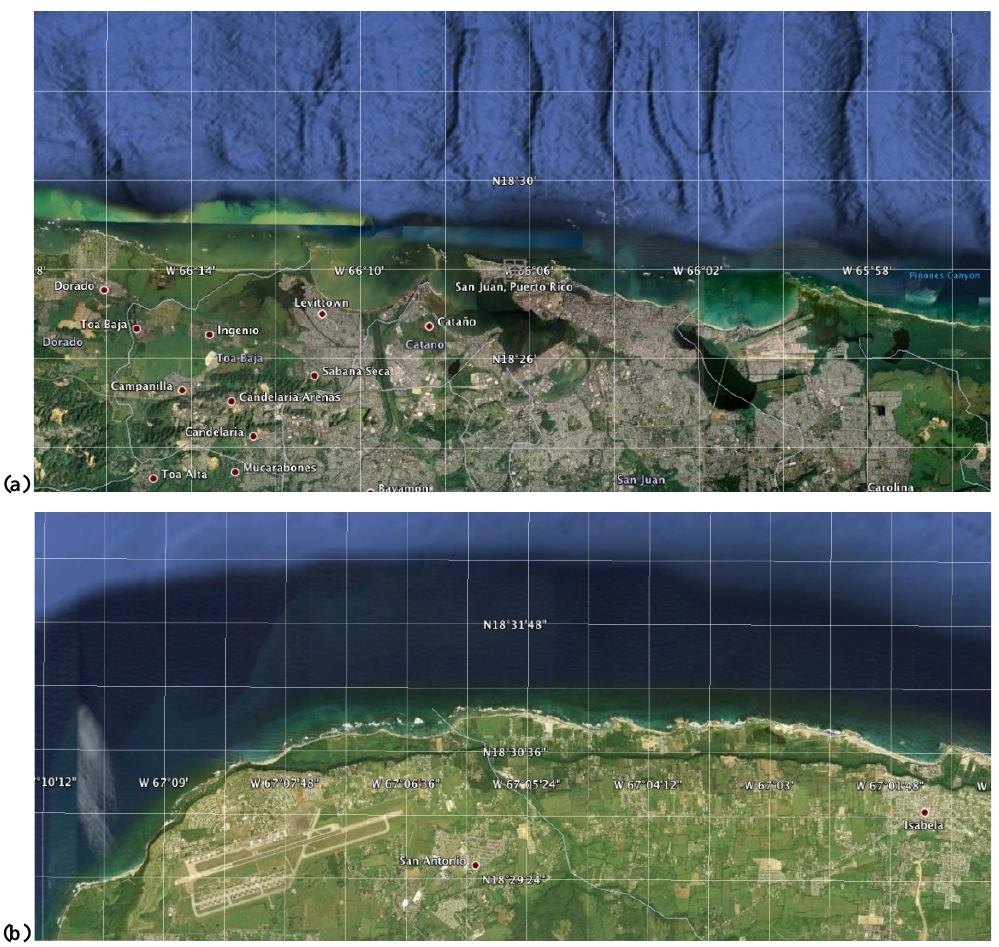
Fig. 12. Aerial photographs of PRNS areas selected for detailed inundation studies of Figs. 13 and 14, near the cities of: (a) San Juan; and (b) Isabela (Google Map, 2010). Note the many submarine canyons and ridges visible in figure (a), off of the middle section of the PRNS near San Juan, as seen in isobath undulations in Fig. 5 and discussed in the